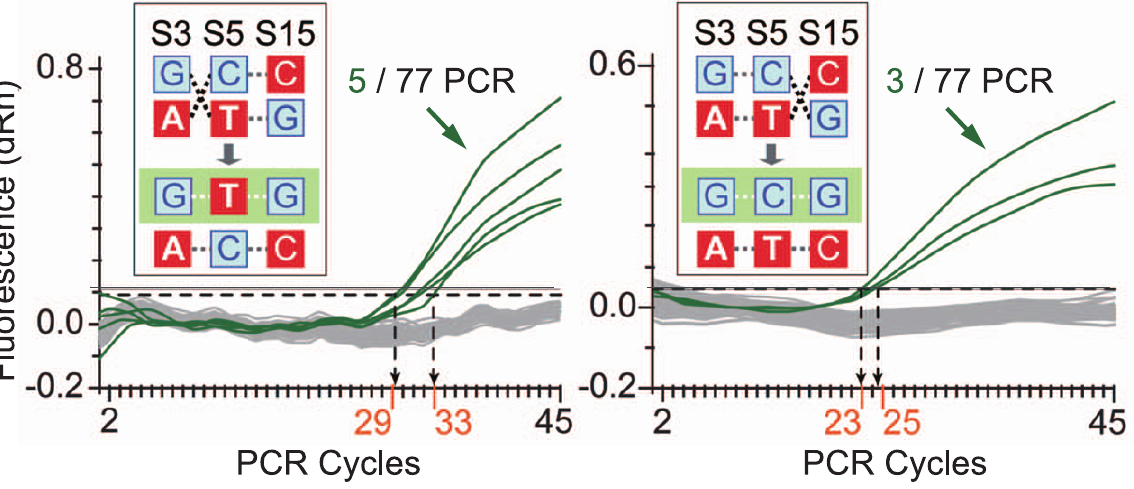
Figure 3. Experimental detection of recombination events in S1–S29. (A) Haplotyping of somatic and sperm DNA. Left: Haplotyping of somatic DNA from 16 JP controls and 19 GE controls (Methods) selected according to the criterion that each sample was heterozygous for at least two of SNPs S1, S3, S5 and S24. DNA sequence containing these four SNPs was in each instance amplified from first PCR product and sequenced (Methods), and crossover points between the S1–S3, S3–S5 or S5–S24 SNP sites were identified based on the four-gamete rule [40]. The maximum distances of these crossover points from AluYi6-AH151 were 815-bp, 763-bp and 540-bp, respectively, in keeping with this young human-specific Alu being a recombination center [11]. Right: Haplotyping of sperm DNA from two Chinese Han individuals without any history of psychiatric disorder. PCR products covering the S2–S5 segment inclusive were each cloned into a pMD18-T vector, and inserts from individual colonies were haplotyped